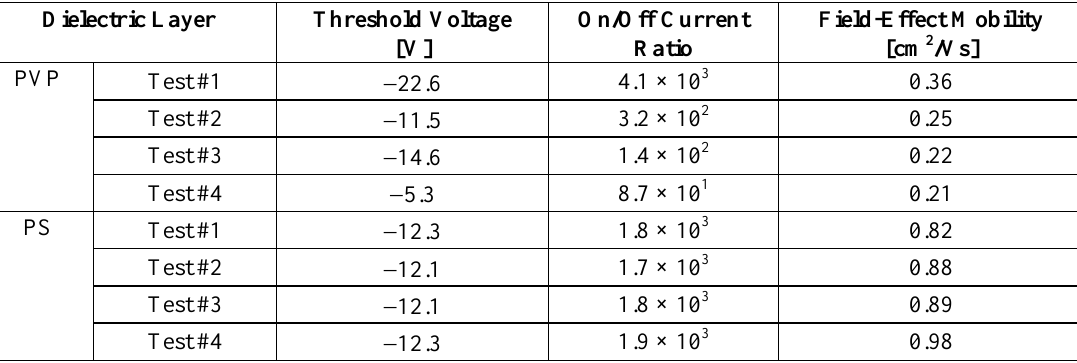
Table 1. Characteristic parameters of the OTFTs with the PVP and PS layers according to the measurement